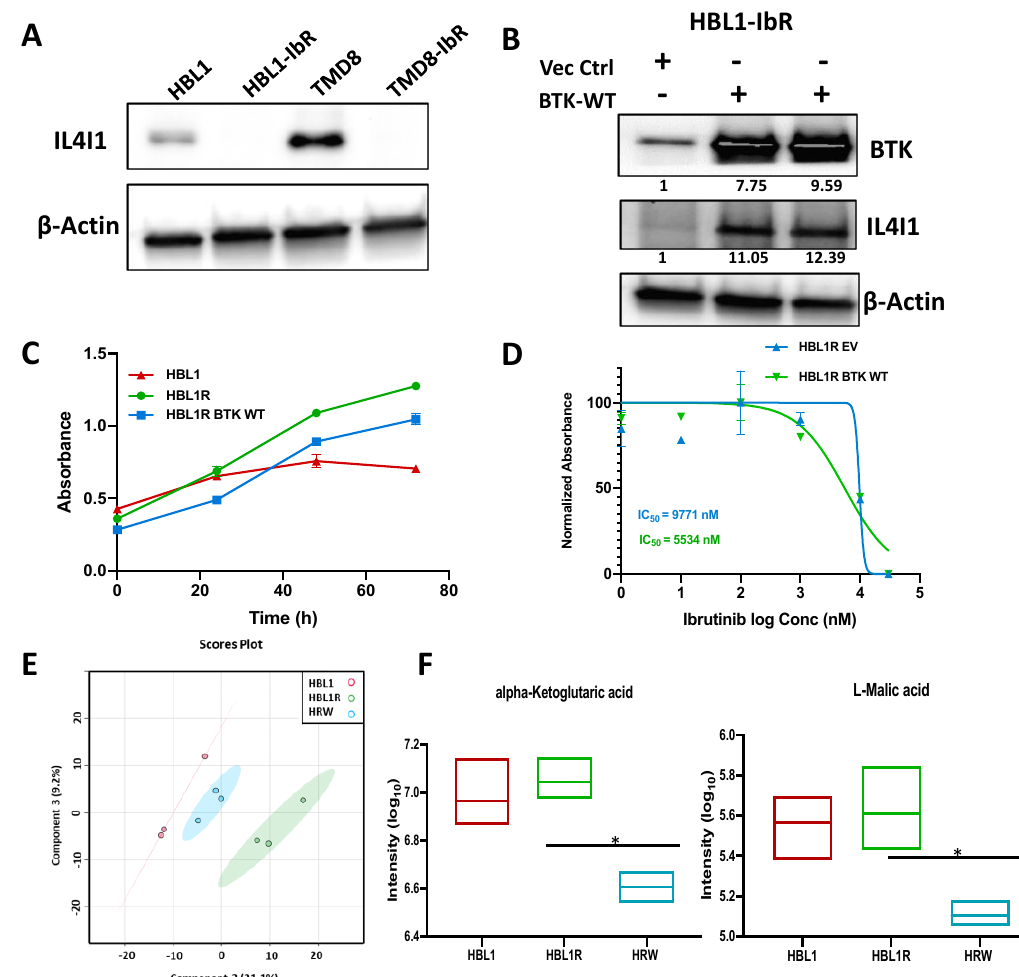
Figure 4. Wild-type BTK expression in the drug-resistant cells hints at the partial metabolic reversal. ( A ) Western blot of baseline IL4I1 expression across the lymphomas and their resistant clones. ( B ) Western blot of IL4I1 expression upon ectopic expression of BTK WT in ibrutinib-resistant HBL1 cells (values below blots represent relative densitometry quantification value compared to vector control). ( C ) MTT proliferation assay to determine cell growth in the WT-BTK-expressing resistant cells compared to their respective parental line. ( D ) Representative IC50 graphs of the WT-BTK expressing HBL1 ibrutinib--resistant lymphomas treated with ibrutinib. (Please note that the ectopic expression of the empty vector alters the basal IC50 in resistant clones.) ( E ) PLS-DA plot depicting the variability in metabolic profiles of HBL1, HBL1R, and HBL1R expressing WT--BTK (HRW). ( F ) Relative signal intensity of TCA metabolites (alpha-ketoglutaric acid and malic acid) across the HBL1 derived cells. * p < 0.05.